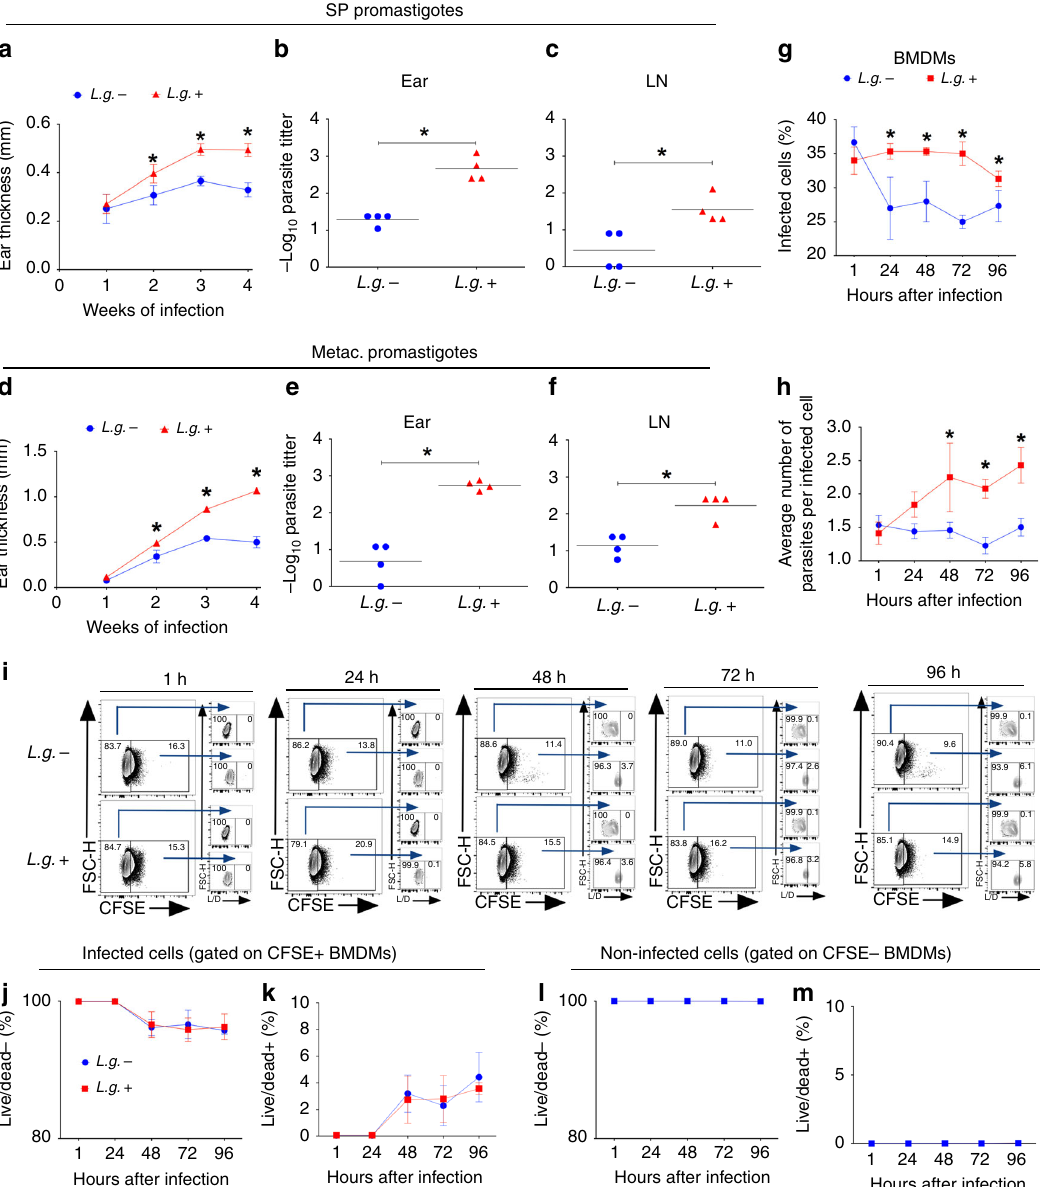
Fig. 2 LRV increases L.g . virulence in vitro and in vivo. a – f C57BL/6 mice ( n = 4 per group) were injected intradermally in the left ear with SP ( a – c ) or metacyclic promastigotes ( d – f ) of L.g . − or L.g . + and ear thicknesses were followed weekly ( a , d ). At 4 w.p.i., parasite titers were determined in the